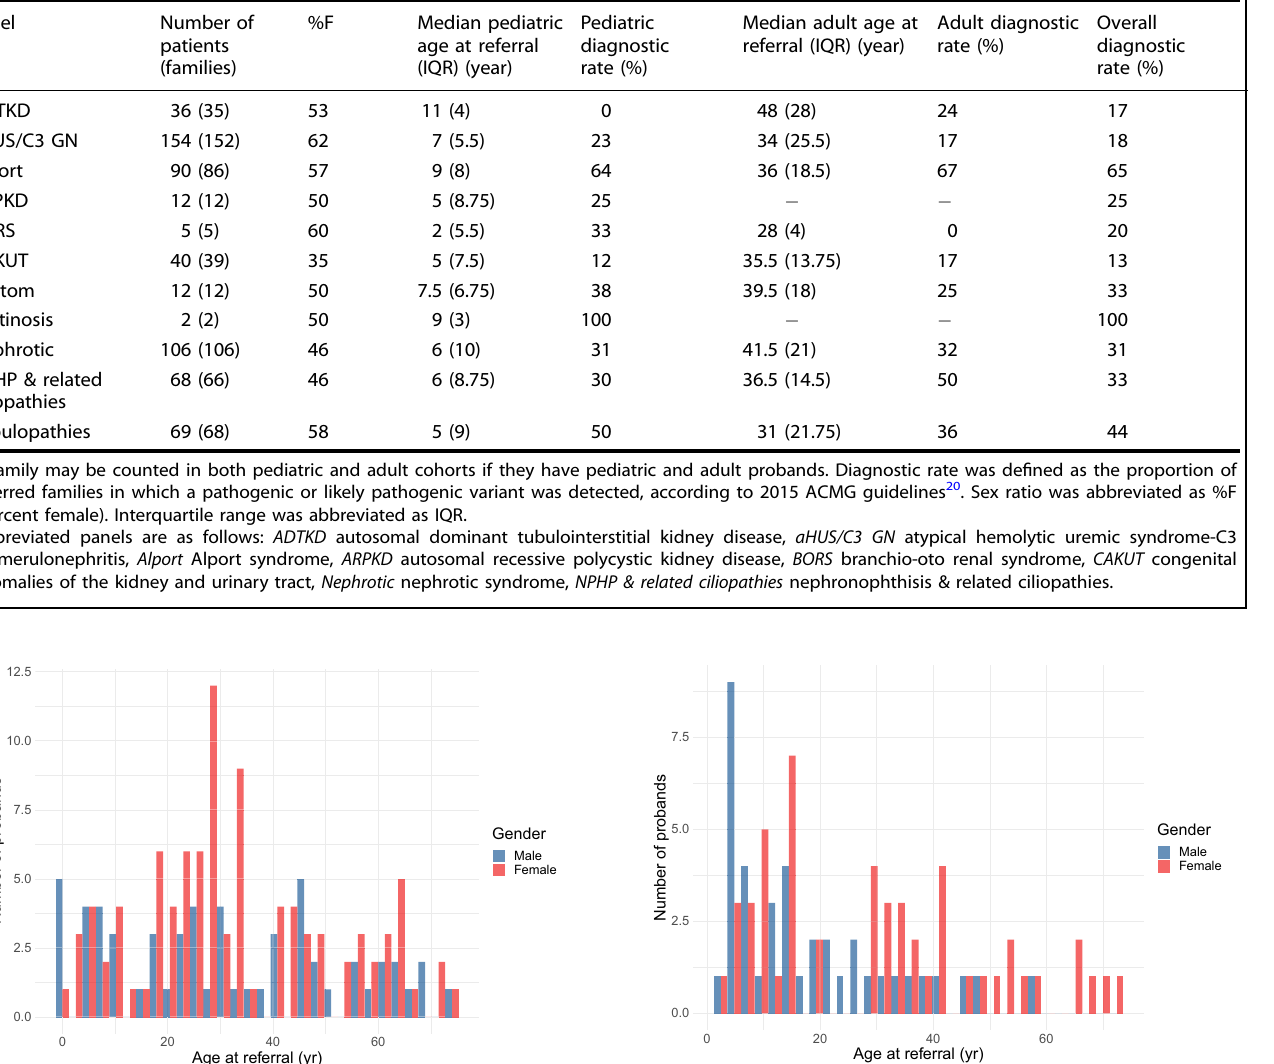
Fig. 2 Age and gender distribution of 154 probands referred for atypical hemolytic uremic syndrome-C3 glomerulonephritis (aHUS/C3 GN) panel testing. Referrals were processed between December 2013 and October 2019.